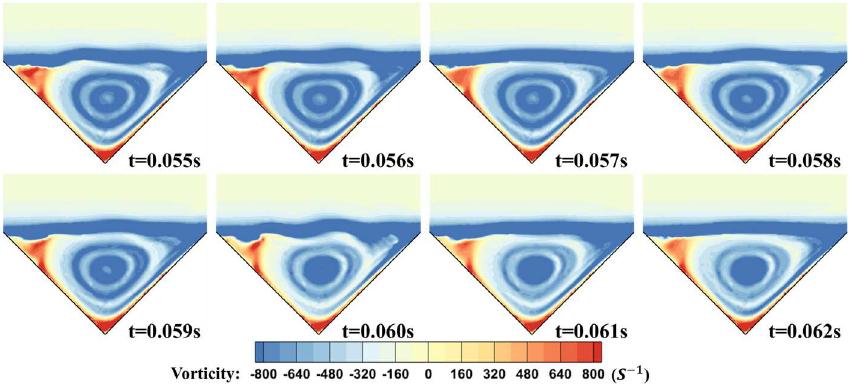
Figure 20. The vorticity contours of boundary vortices within grooves with AR = 2 at Re = 5.44 × 10 4 .